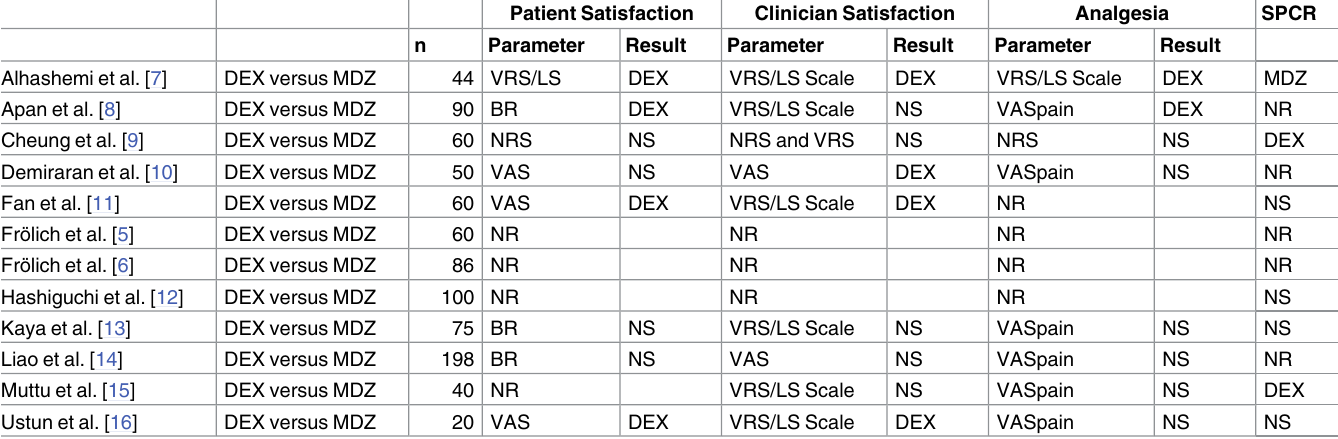
Table 4. Results for Patient Satisfaction, Clinician Satisfaction, Analgesia and Sedation